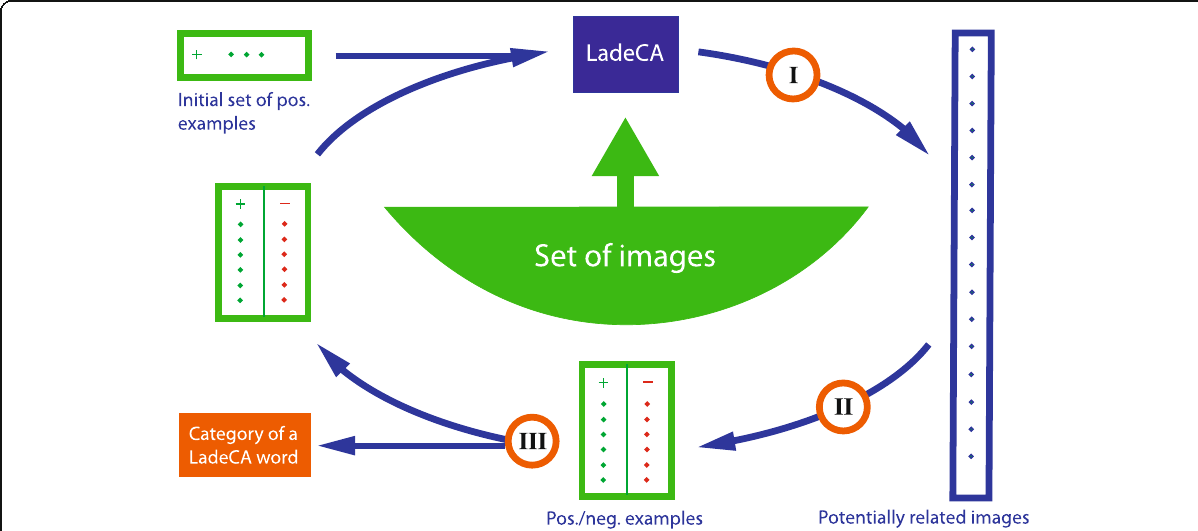
Fig. 5 Schematic representation of the LadeCA word category formation process. Set of images: basis set used for the creation of classifiers. Initial set: one or more related images specified by the user or suggested by LadeCA based on analysis or clustering of the given set of images (or a preexisting LadeCA word). Step I: from the given set of positive and negative examples that describe a category (or the initial set),